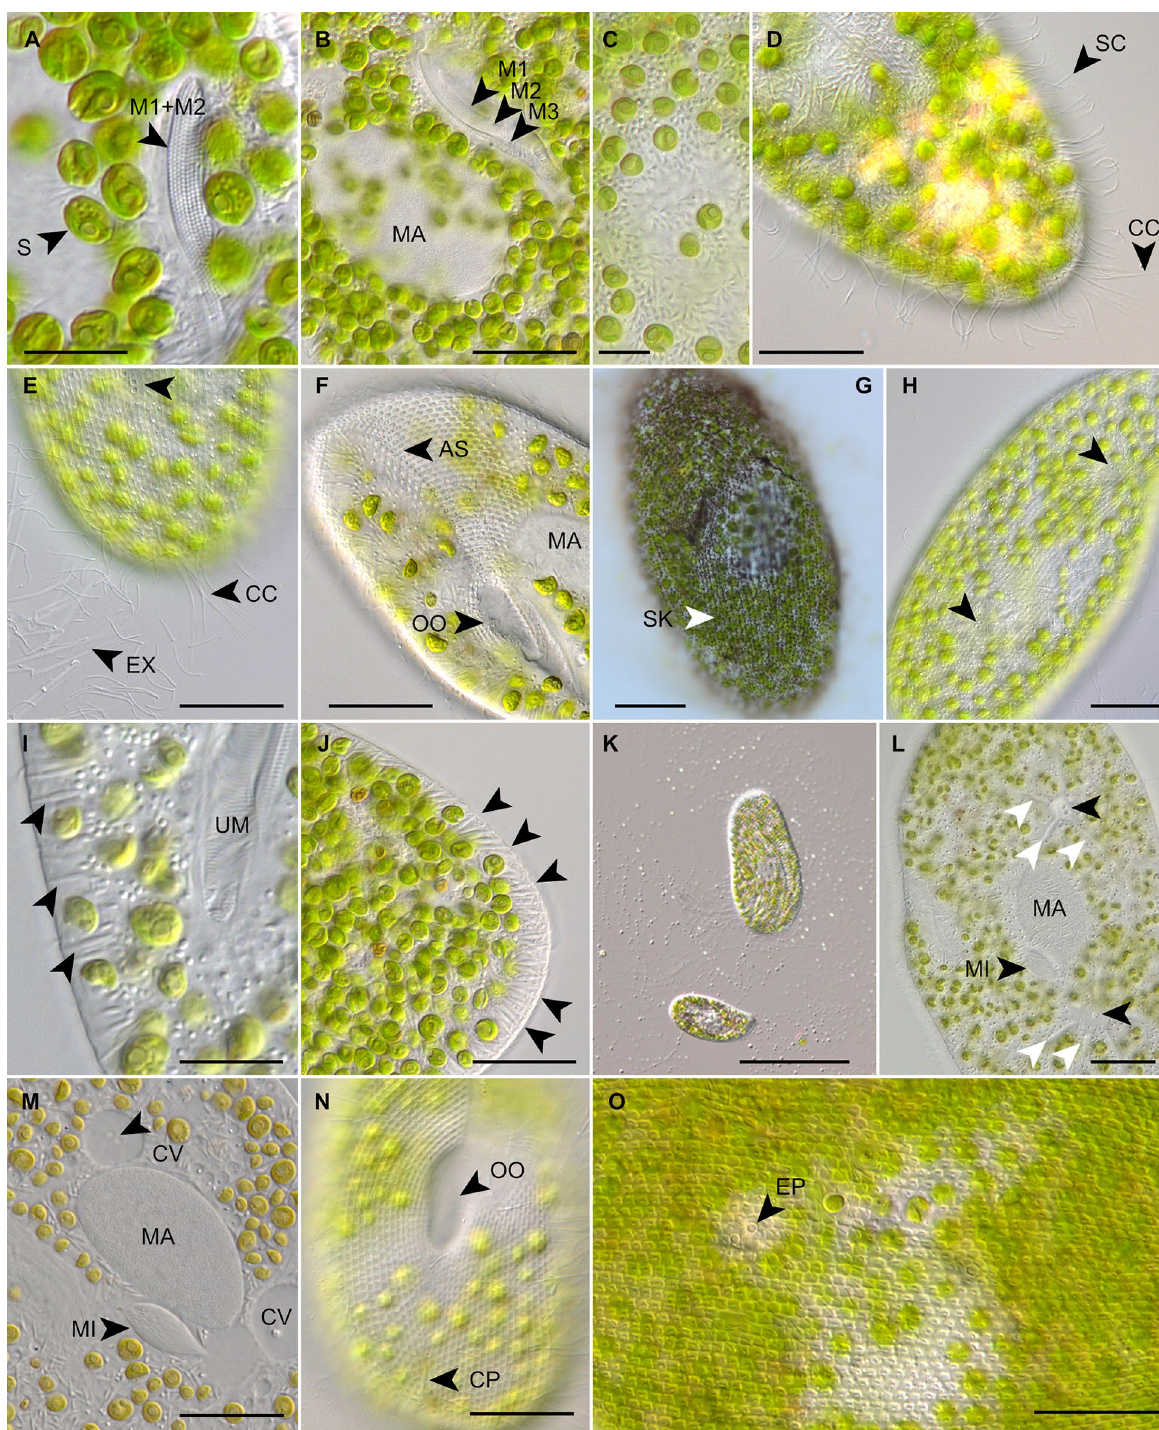
Figure 6. Morphological details of the Paramecium bursaria species complex from specimens of strains PB-25 ( A ), CCAP 1660/30 ( B ), SAG 2645 ( C , F , G , I , L – N ), CCAP 1660/36 ( D ), CCAP 1660/26 ( E , H ), CCAP 1660/30 ( J , O ), CCAP 1660/16 ( K ) in vivo ( A – F , H – O ) and after silver nitrate staining ( G ). Adoral membranelles ( A , B ), endosymbiotic algae Micractinium conductrix ( C ), caudal and somatic cilia ( D ), arrows denote excretory pores of the contractile vacuoles: extruded extrusomes are shown and caudal cilia ( E ), ventral views showing the preoral suture and the oral opening ( F ), the ciliary pattern ( G ), arrows denote excretory pores of the contractile vacuoles ( H ), trichocysts and symbiotic algae underneath the pellicula ( I , J ), cell size variations ( K ), radial collecting channels (white arrows) and excretory pores (black arrows) of contractile vacuoles ( L ), macro- and micronucleus ( M ), cytopyge and characteristic rectangular pellicular pattern ( N ), pattern of the pellicula ( O ). AS anterior suture, CC caudal cilia, CP cytopyge (cell after), CV contractile vacuole, EP excretory pore of a contractile vacuole, EX extrusomes, M1–M3 membranelles 1–3, MA macronucleus, MI micronucleus, OO oral opening, S symbiotic algae, SC somatic cilia, SK somatic kineties, UM undulating membrane. Scale bars 10 µm ( A , I ), 20 µm ( B , D – H , J , L – O ), 50 µm ( K